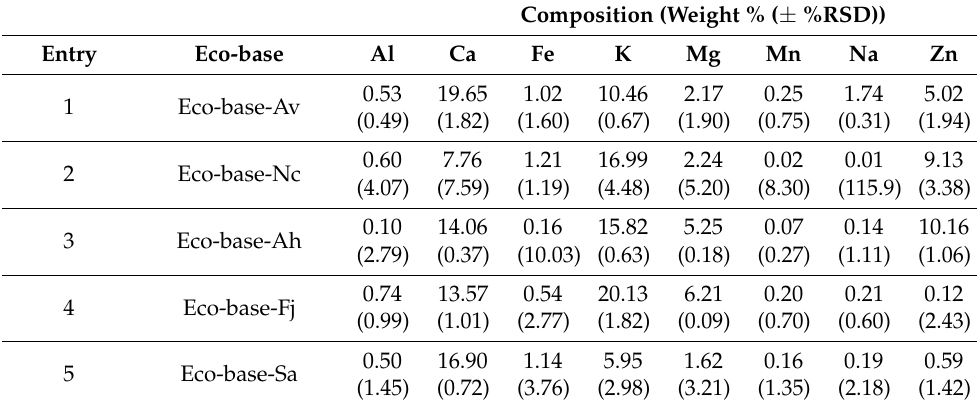
Table 2. Elemental composition of the Eco-bases determined by MP-AES analyses.